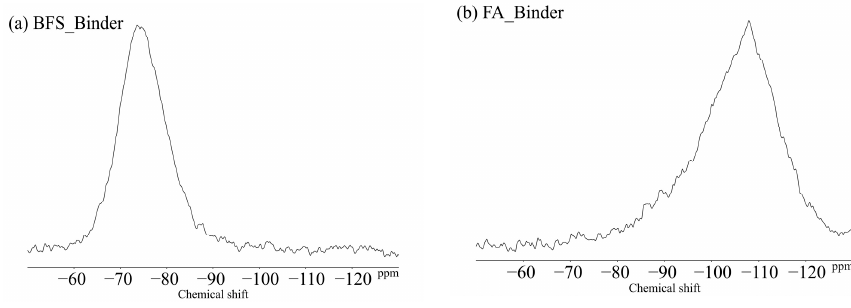
Figure 11. Solid-state 29 Si MAS NMR chemical shifts for ( a ) BFS and ( b ) FA-binders.